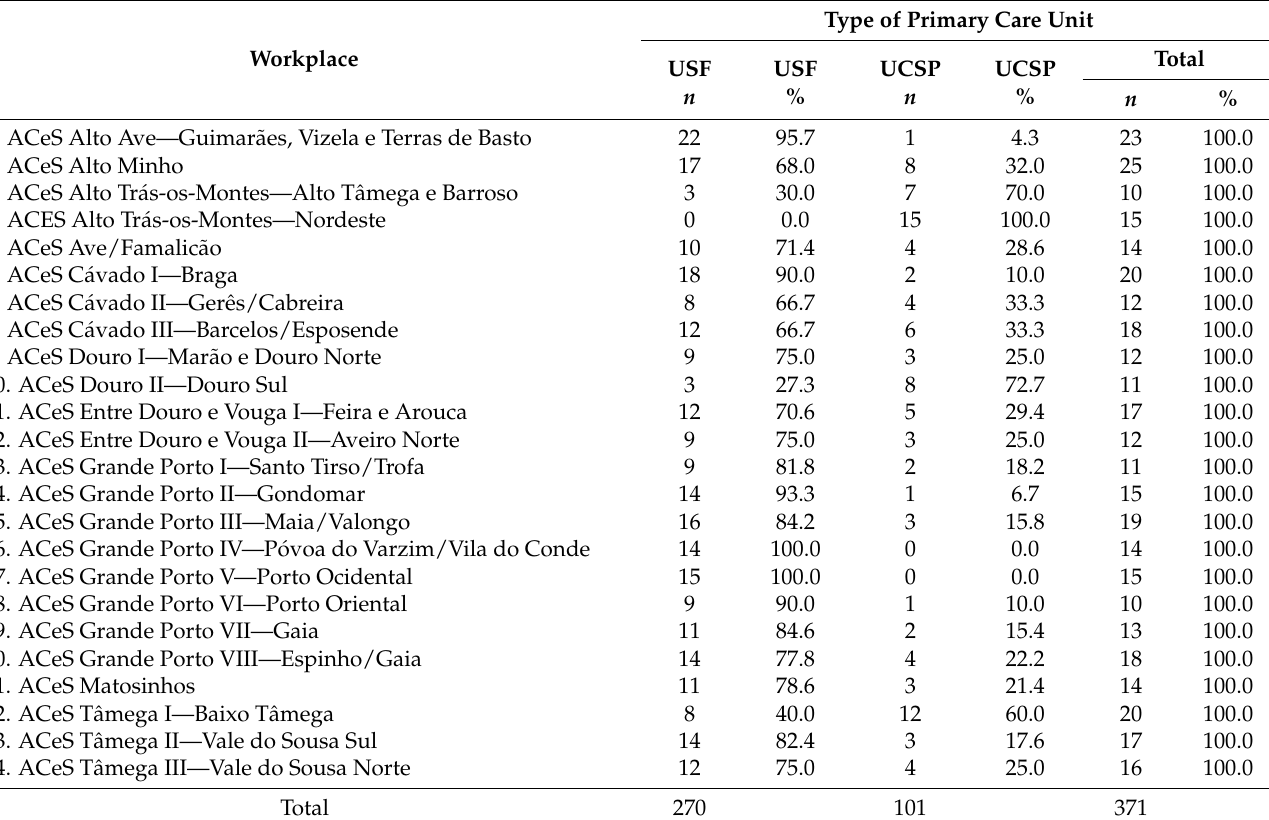
Table A2. Descriptive analysis of North Regional Health Administration by type of primary care